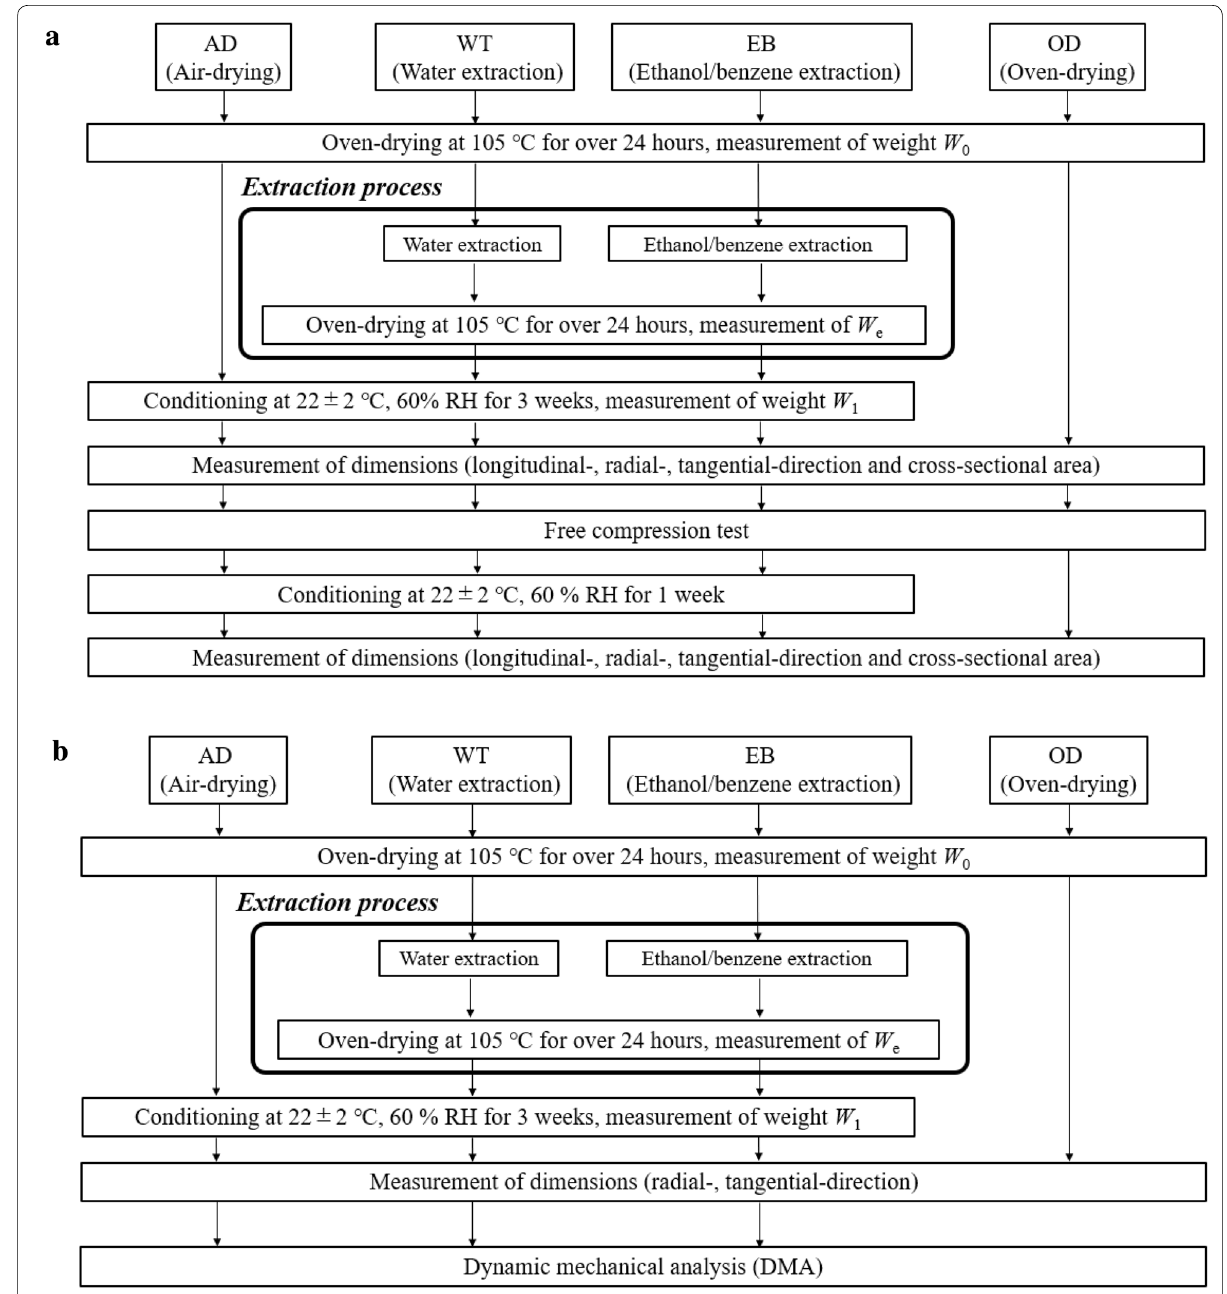
Fig. 1 Experimental procedures for: a free compression test, 5 replicates of disk-shaped specimen for AD, WT, EB and OD; and b for dynamic mechanical analysis (DMA), 5 replicates of rectangular specimen for AD, WT and